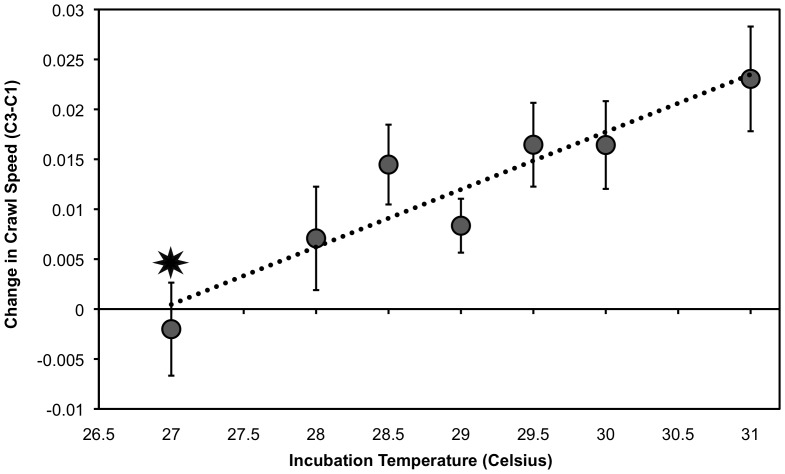
Incubation temperature's effect on mean change in crawl speed (C3-C1) ± S.E.M in 2011.On average, hatchlings from 27°C slowed down while all other hatchlings sped up between crawls (F2,6 = 7.010, p = 0.01). Star denotes statistical difference. A linear relationship between these data is presented (R2 = 0.87). [Sample size: 27°C n = 5; 28°C n = 5; 28.5°C n = 12; 29°C n = 15; 29.5 n = 11; 30°C n = 6; 31 n = 3].